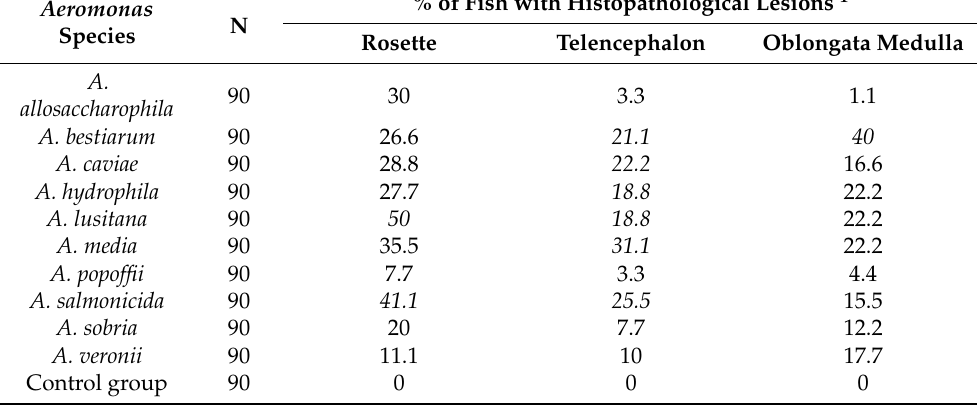
Table 3. Aeromonas species and histopathological lesions observed in nasal epithelium or rosette, telencephalon, and oblongata medulla changes (%), observed in rainbow trout fingerlings infected with different Aeromonas species.